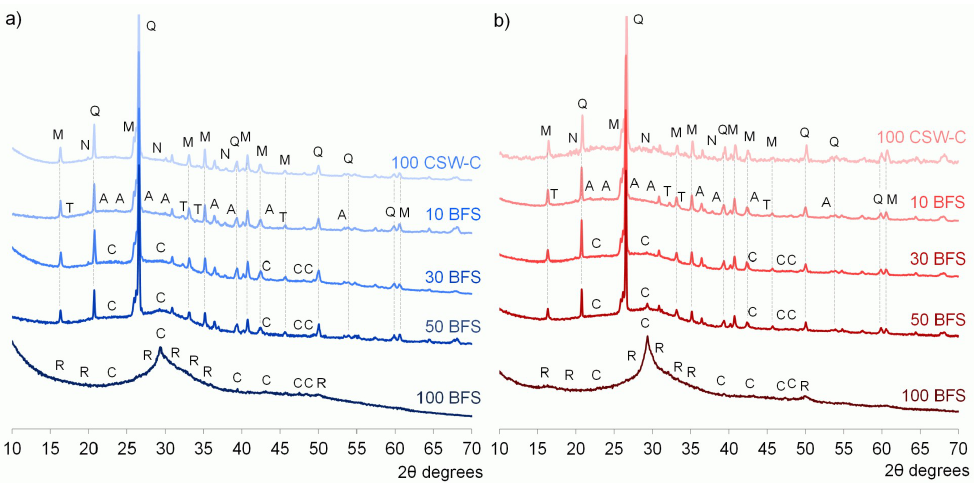
Figure 6. The powdered X-ray diffraction (XRD) spectra for the CSW/BFS blended pastes prepared with 10, 30, and 50 wt % BFS, cured at: ( a ) 20 °C for 28 days; ( b ) 65 °C for 7 days. Quartz (Q, SiO 2 ); Mullite (M, Al 6 Si 2 O 13 ); Calcite (C, CaCO 3 ); Anorthite (A, CaAl 2 Si 2 O 8 ); Natron (N, Na 2 CO 3 ·10H 2 O); Rankinite (R, Ca 3 Si 2 O 7 ); Thermonatrite (T, Na 2 CO 3 ·H 2 O).